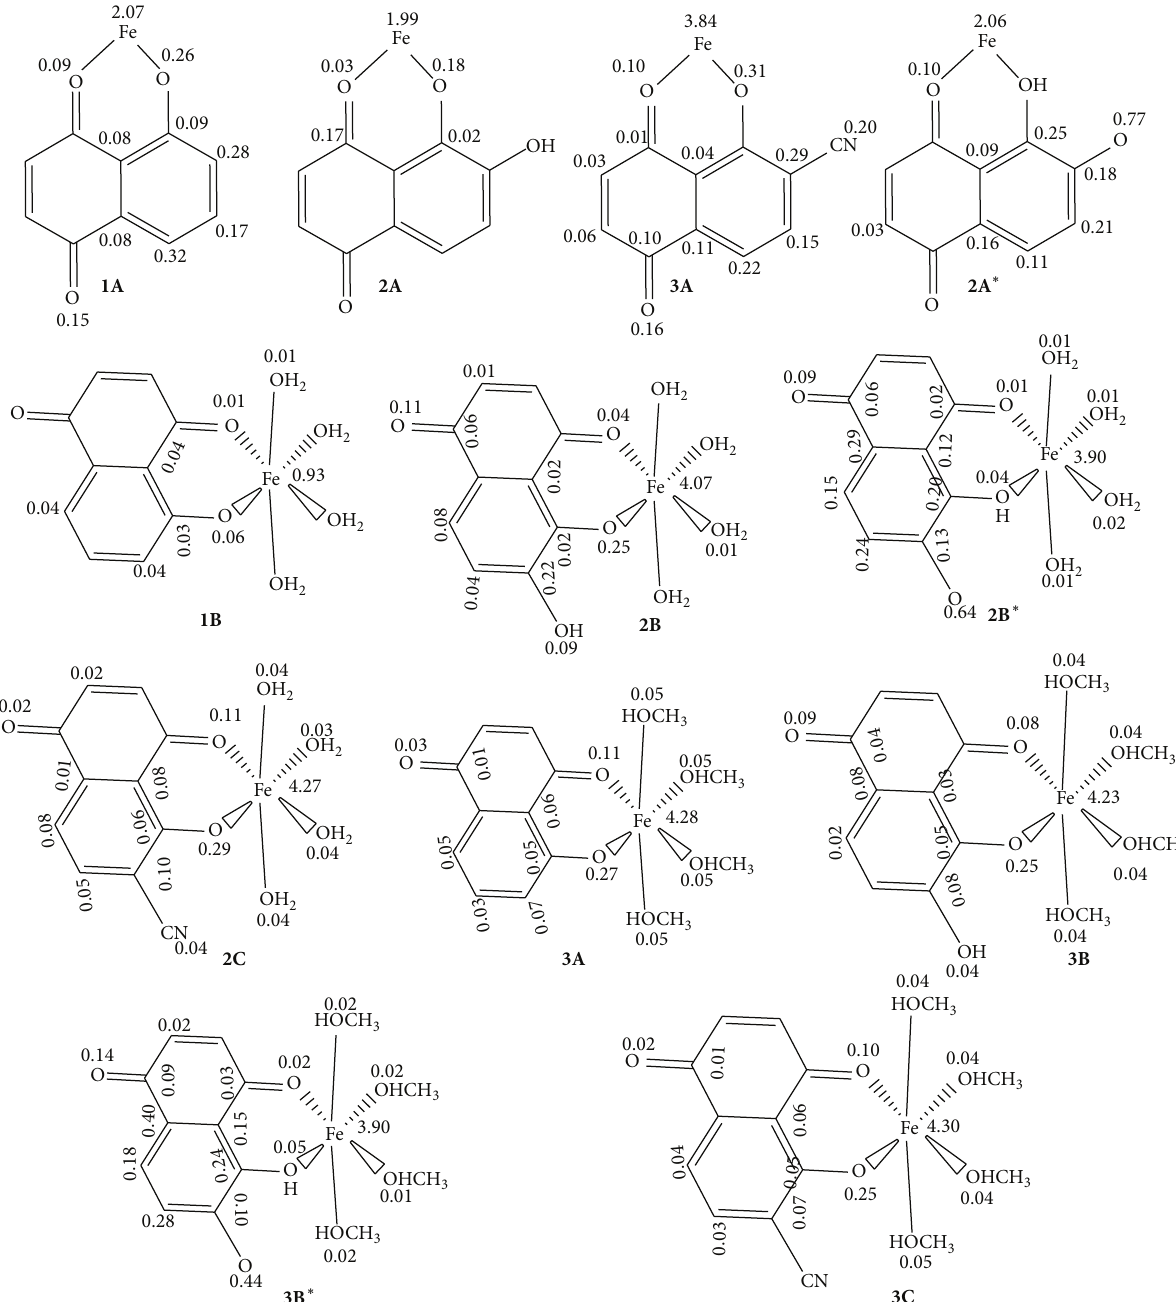
Figure 3: Mulliken spin densities of the radicals of the chelates and complexes